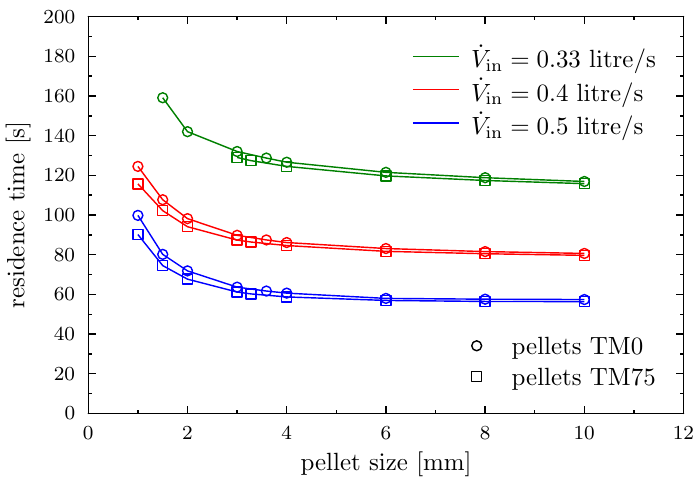
Figure 8. Dependency of mean residence time for pellets TM0 and TM75 with various diameters and inlet flow